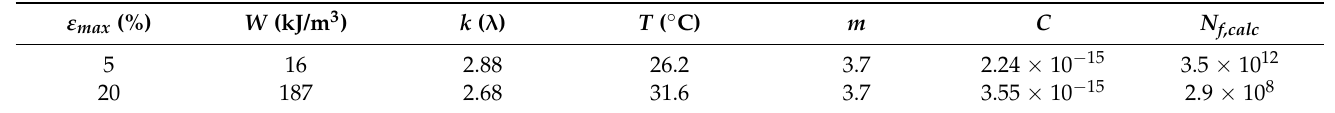
Table 2. Overview of the values used to calculate the number of cycles to failure for interrupted tests using Equation